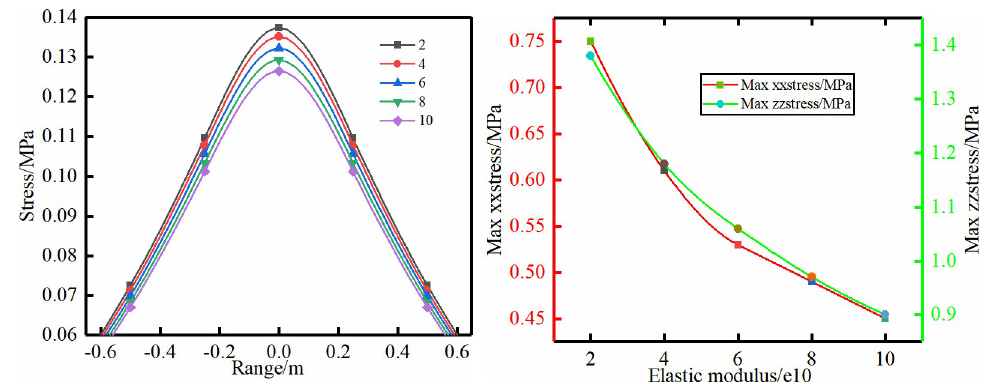
Fig 3. Different elastic modulus.